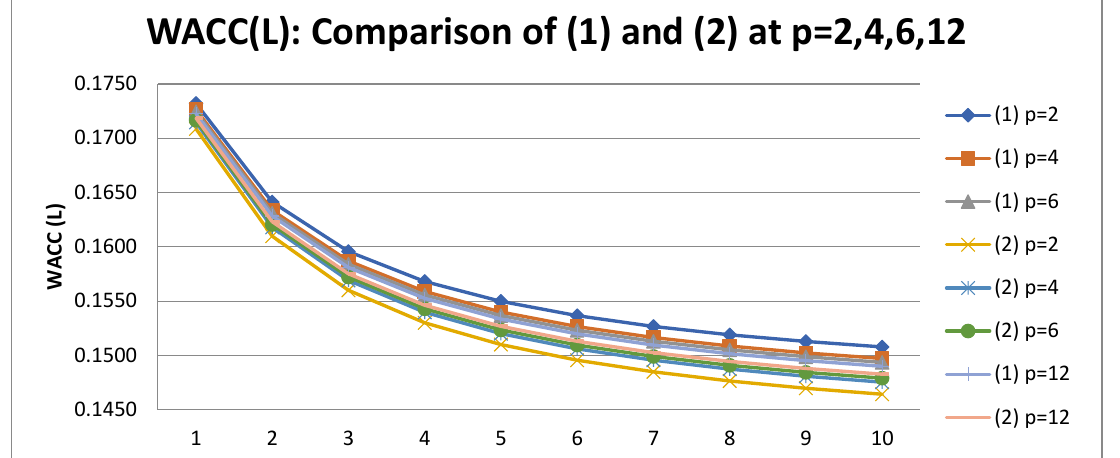
Figure 10. The comparison of the dependence of the WACC on the leverage level ( L ) of a six-year-old company for profit tax payments that were (1) made at the end of the financial period and (2) made at the beginning of the financial period (i.e., advance payments) with frequencies of p = 2, 4, 6 and 12.